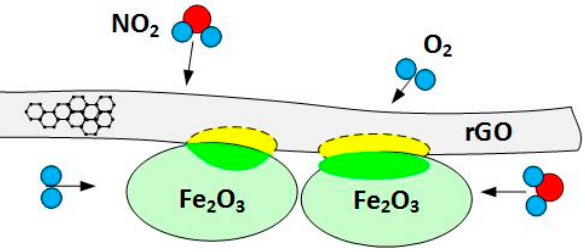
Figure 11. Interaction of Fe 2 O 3 grains with rGO flakes leading to the formation of hole accumula- tion regions in rGO flakes.